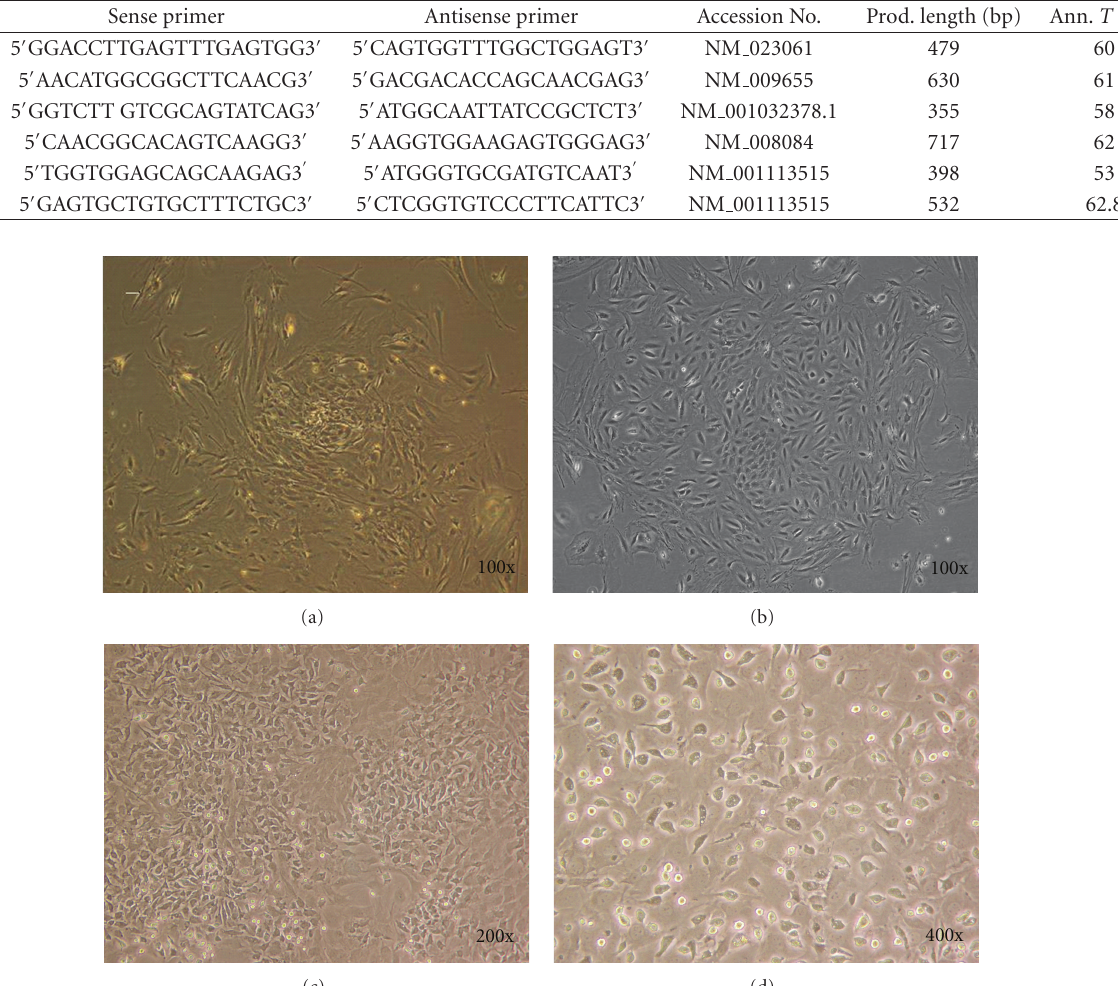
Figure 1: Characteristics of isolated and in vitro mouse DPSC colony formation after cultured DPSC at the first passage (a and b). Cell after 48 hours after culture (c) and fibroblastic-like cells shape